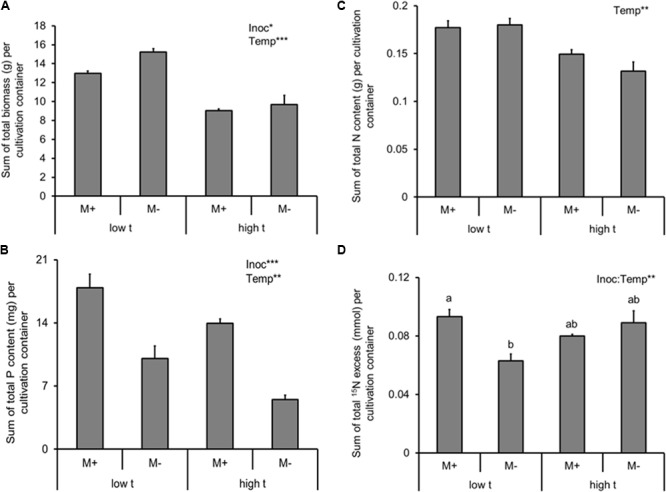
Dry biomass (A), phosphorus (P) content (B), nitrogen (N) content (C) of the experimental plants (shoot and roots combined) and 15N excess (i.e., 15N derived from the isotopically labeled clover biomass added to the RFC), (D) detected in the plant biomass (shoot and roots combined), summed together for cultivation containers planted with both of the Panicum species (mixed cultures) as affected by mycorrhizal inoculation (M+, mycorrhizal inoculum added; M-, non-mycorrhizal control) and cultivation temperature (low t, 25°C during daytime; high t, 36°C during daytime). Mean values ± standard errors are shown (n = 4 for M+ high t treatment, n = 3 for all the other treatments). Significances of inoculation (Inoc), cultivation temperature (Temp), and their interaction are indicated (factors with p ≥ 0.05 are not shown, ∗∗∗p < 0.001, ∗∗0.001 ≤p < 0.01, ∗0.01 ≤p < 0.05). Different letters at the individual bars indicate significant differences between the means at p < 0.05.